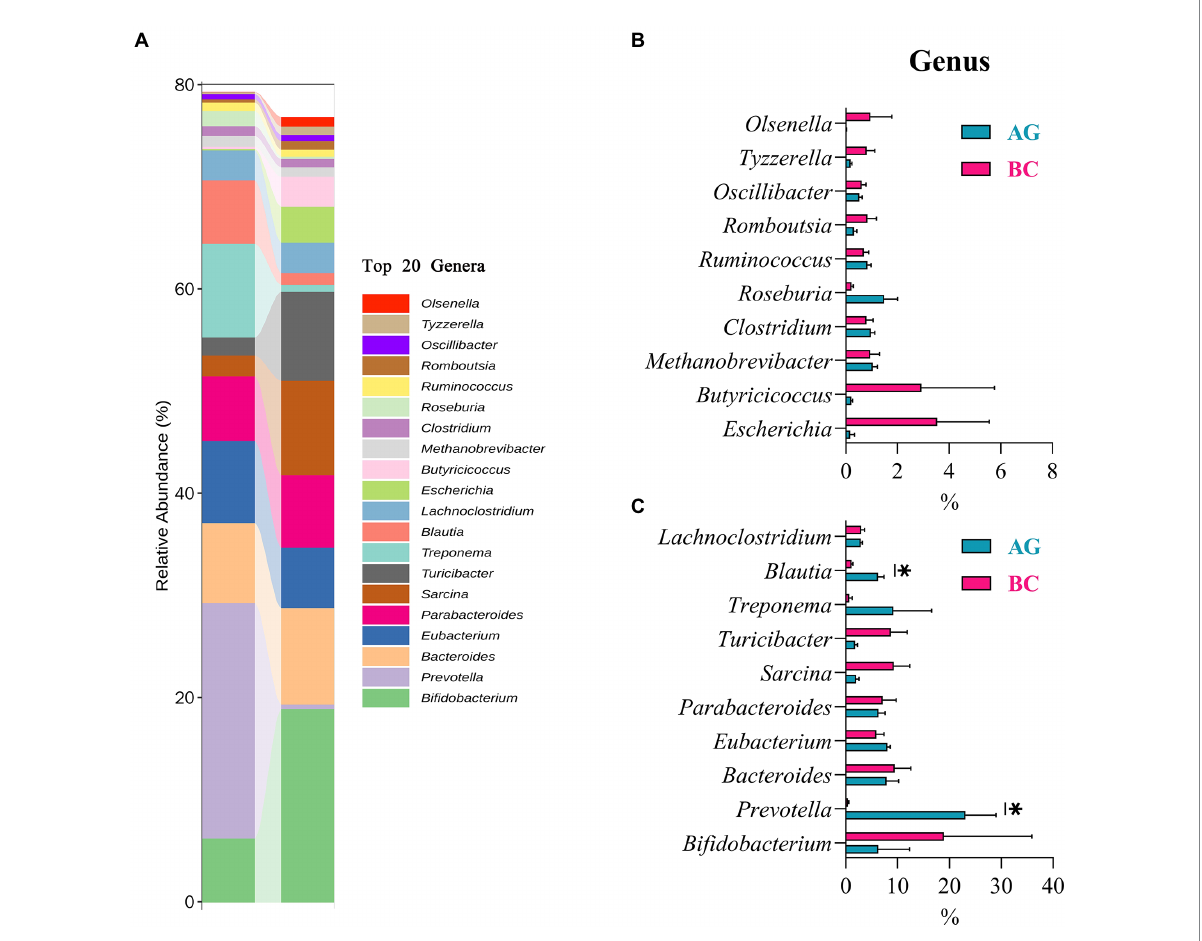
FIGURE 6 The genera composition and the differentials in the gut microbiota between Xinjiang brown cattle (BC) and Angus cattle (AG; top 20 genera). ( n = 5 in each breed). The relative abundance of genera composition (A) ; The differential genera in the different relative abundance (B,C) . Values were expressed as means ± SEM. * denotes p < 0.05 indicating significant